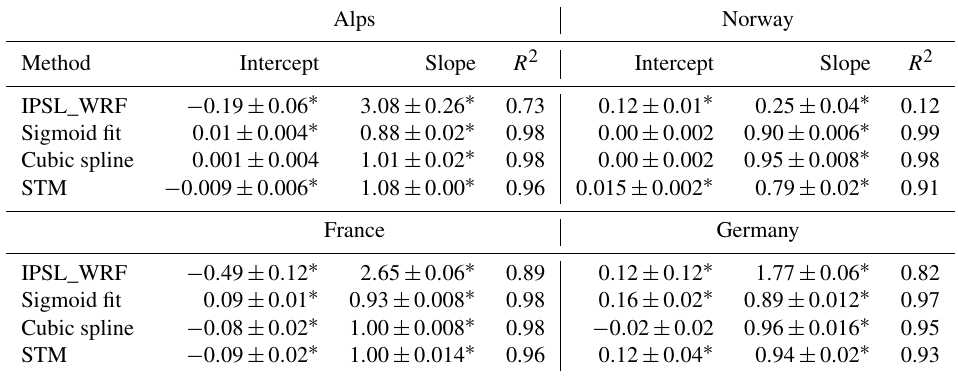
Table 3. Summary statistics of the linear relationship between reconstructed and reanalysis snowfall over the Alps, Norway, France, and